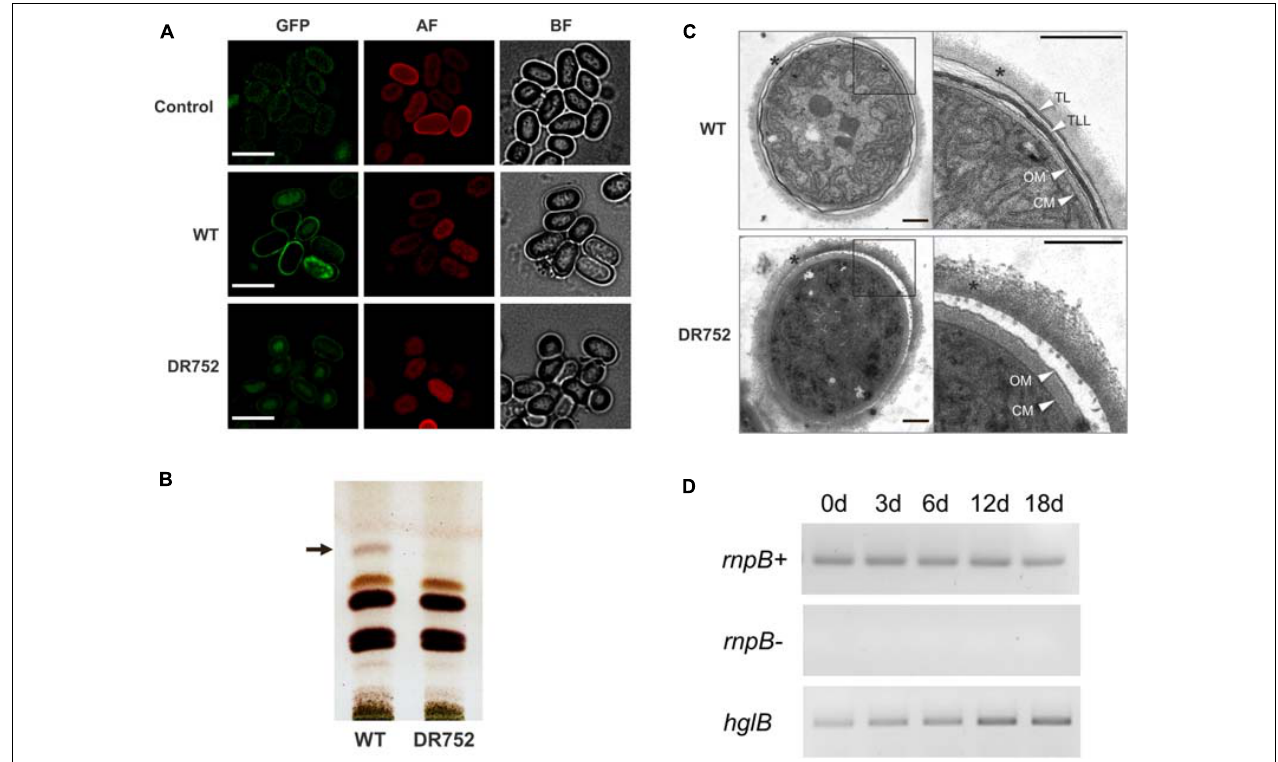
FIGURE 4 | Analysis of glycolipids and expression of hglB during akinetes formation. (A) Akinete envelope stained with the green fluorescent dye BODIPY. Control, mutant akinetes without BODIPY staining; BF, bright field; GFP, green fluorescent protein filter; AF, autofluorescence red. Bars, 7.5 µ m. (B) Thin-layer chromatogram of lipid extracts from liquid cultures induced to develop akinetes in low light for 4 months. The position of the glycolipid band corresponding to the heterocyst-specific glycolipid HG 26 -diol is indicated by an arrow. (C) Transmission electron micrographs (TEM) of akinetes of WT and mutant DR752. Right panels show the magnified view of akinete envelope, indicated by square. Star indicates the exopolysaccharide layer. White arrowheads indicate the following layers: TL, thin laminated layer; TLL, thick laminated layer; CM, cell membrane; OM, outer membrane. The empty space between outer membrane and polysaccharide layer is a dehydration artifact of the sample preparation procedure. Bars, 0.5 µ m. (D) Expression analysis of hglB in the WT culture during akinete induction performed by semi-quantitative RT-PCR. rnpB (RNase P RNA coding gene) was used as a loading control with ( rnpB +) and without reverse transcriptase ( rnpB -). The primers used for semi-quantitative RT-PCR are RT rnpBFw, RT rnpBRv, RT hglBFw, and RT hglBRv; the sequences of the primers are listed in Supplementary Table 2 .